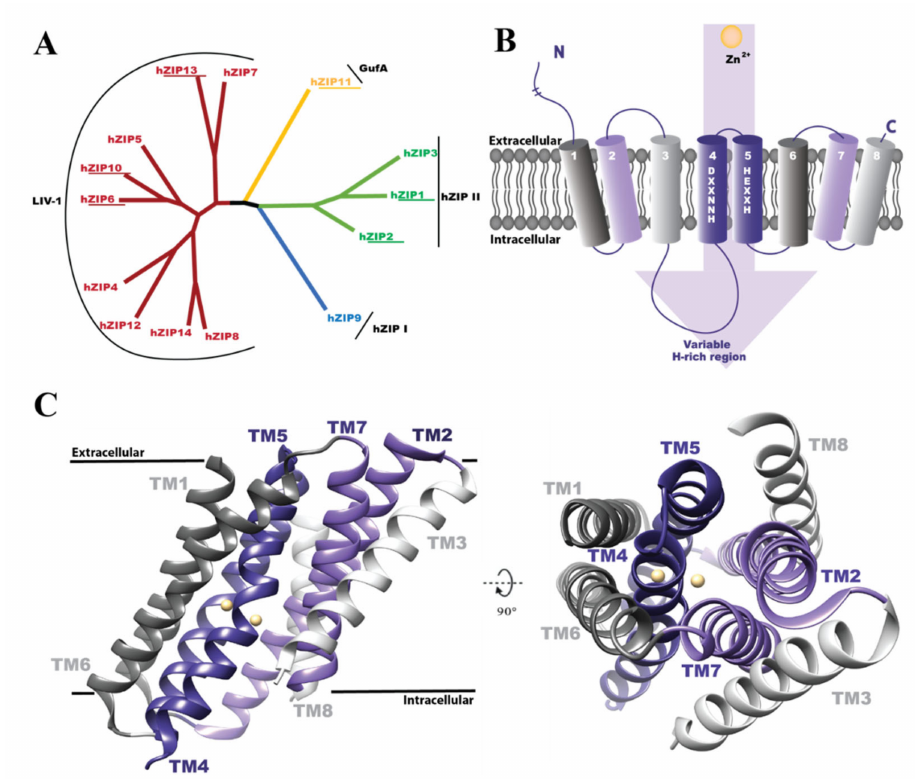
Figure 1. Overview of the Zrt-, Irt-like (ZIP) family of zinc transporters. ( A ) Phylogenetic distribution of the 14 human ZIP transporters (hZIP1-14) classified into four subfamilies, i.e., hZIP I, hZIP II, GufA, and LIV-1. The members investigated in this study are underlined. The phylogenetic tree was constructed using the MEGAX software (https://www.megasoftware.net/) [46]. ( B ) The predicted topology of hZIPs with selected characteristic features indicated. hZIPs likely form eight transmembrane segments (TMs), and the conserved motifs in TM4 and 5 (i.e., HNNXXD and HEXXH, respectively) establish a binuclear metal center. TM3 and 4 are linked by a variable loop containing a histidine-(H)-rich domain. The human ZIPs harbor N-terminal tails of varying length (from ≈ 6 aa in hZIP2 to ≈ 407 aa in hZIP10) and a short C-terminus, both oriented towards the extracellular side. ( C ) The only available structure of full-length ZIP from Bordetella bronchiseptica (BbZIP) (PDB ID:5TSB) [26,27]. The structure reveals that the TMs arrange pseudo-symmetrically into two domains: TM1, 4, 5, and 6 (dark shades) and TM2, 3, 7, and 8 (light shades). A central binuclear center has been suggested to be involved in Zn 2+ transfer (yellow spheres) [27]. Side and top views are shown (left and right panels,